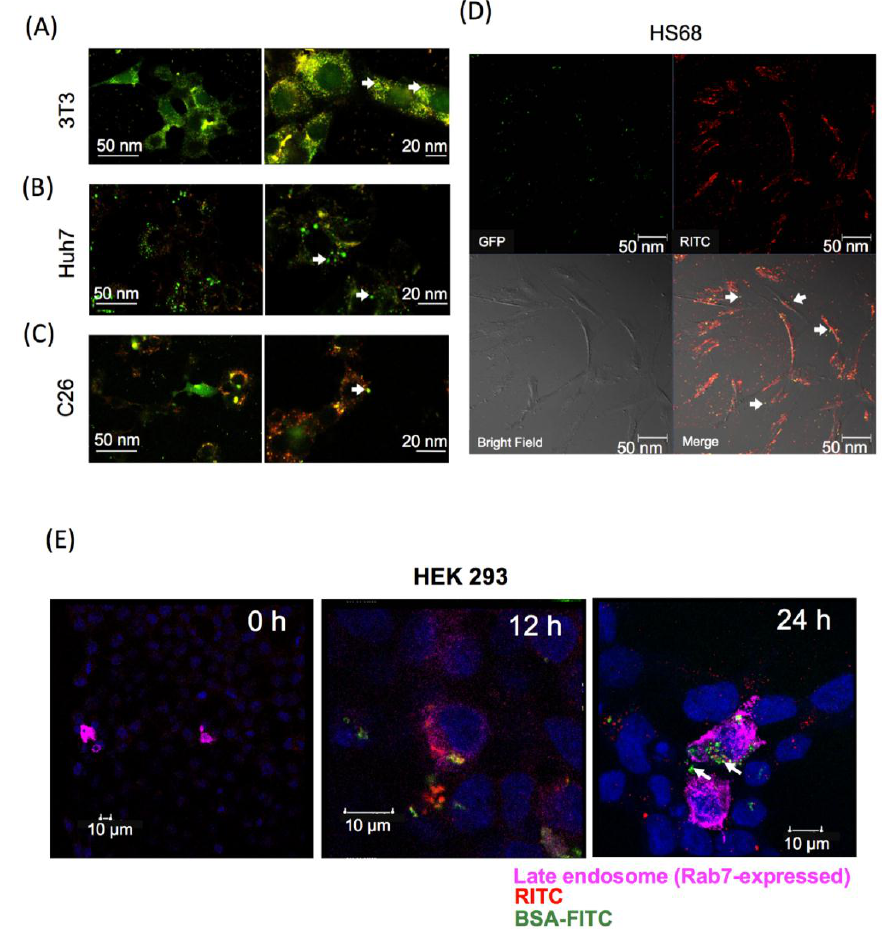
Figure 6. Intracellular protein release from GR-PEI NPs. Confocal laser microscopic images of intracellular protein release. The tomography of cells by confocal laser microscope demonstrated the intracellular BSA-FITC was released from GR-PEI NPs in 3T3 fibroblast cells ( A ), Huh7 hepatoma cells ( B ), C26 colon adenocarcinoma cells ( C ). GFP was released from HS68 fibroblast cells ( D ). Rab7 was used as late endosome tracker. The sub-cellular localization of BSA-FITC and GR-PEI NPs was observed in HEK293 cells that were transfected with late endosome marker, Rab7, (Bar: 10 μm) ( E ). GR-PEI NPs were shown as red signals; BSA-FITC and GFP were shown as green signals; Endosome marker Rab7 was shown as purple pink signals (Alexa Fluor 647, Thermo Fisher, Waltham, MA, USA). Co-localization of GR-PEI NPs and BSA-FITC was shown in yellow.